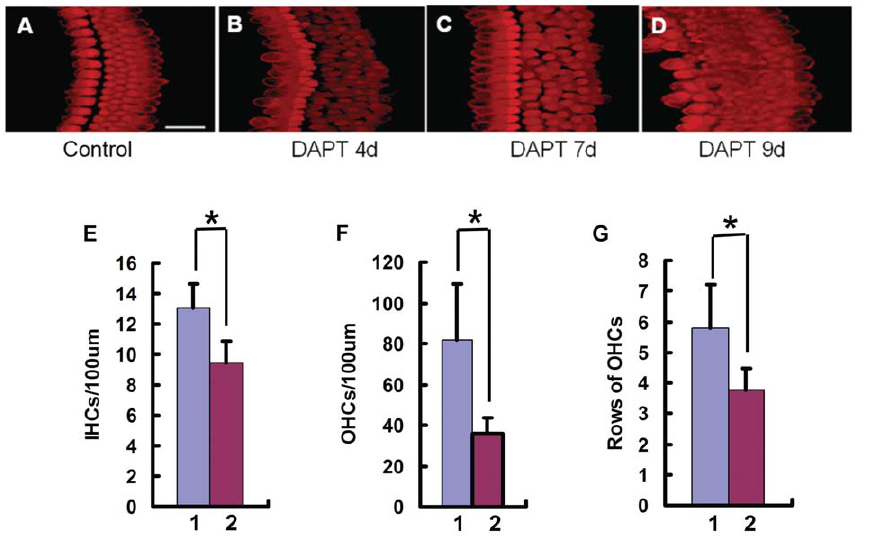
Figure 2. DAPT treatment significantly increases the number of IHCs and OHCs in the cultured P0 rat Organ of Corti. A: Control culture without treatment; B–D: The cultured Organ of Corti treated with DATP for 4, 7 and 9 days. E, F and G: Cell counts of IHCs and OHCs, as well as the rows of OHCs in the cultures. In the abscissa, 1 means with DAPT treatment, 2 means c.